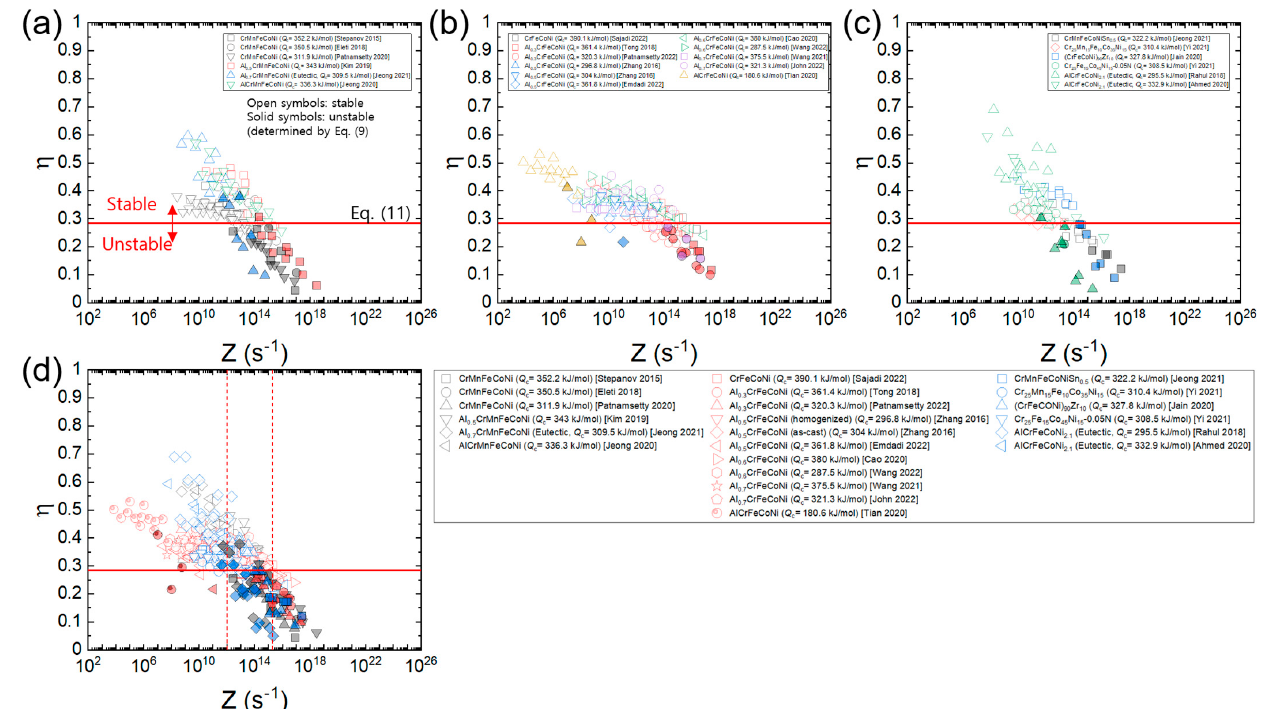
instability becomes more dominant as Z increases.